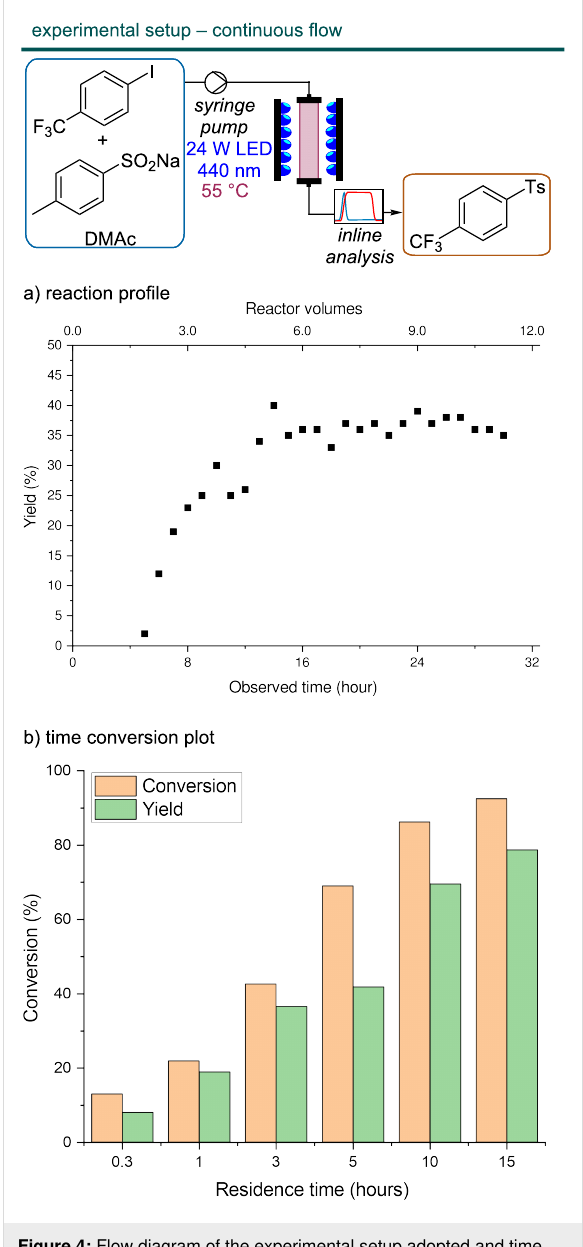
Figure 4: Flow diagram of the experimental setup adopted and time necessary to obtain steady-state conditions. (a) Reaction profile for a residence time of 3 hours. Stable conditions are obtained after about 12 h, because of the low flow rate some delay is also due to dead volume between the reactor and the NMR spectrometer used for reac- tion monitoring. For example, the NMR flow cell volume, about 1 mL, is alone responsible for 100 minutes of delay. (b) Time conversion plot, almost full conversion is observed after 15 hours, comparable with batch results (22